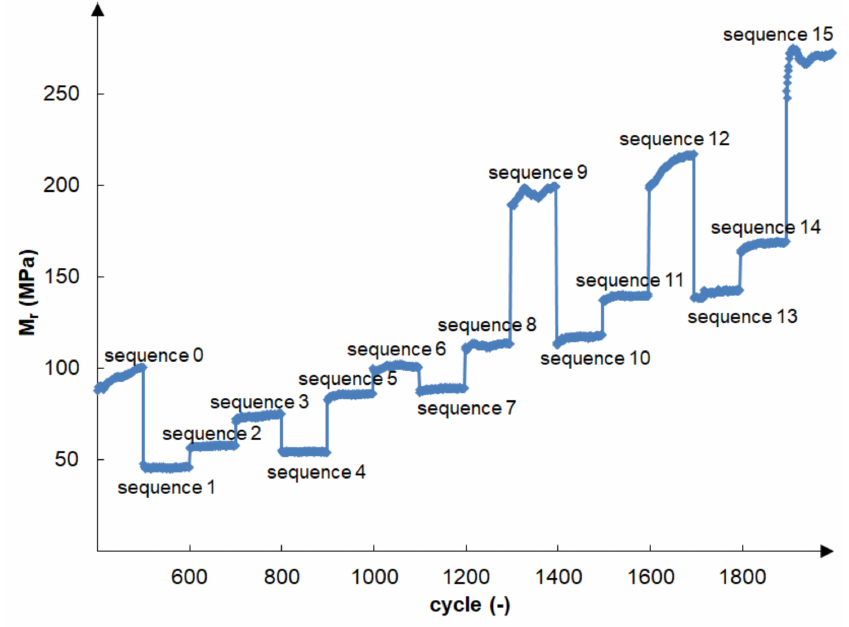
Figure 7. Variation in the resilient modulus in all test cycles (see Table 2) for sample (grSa+3.0%C) compacted by the MP method and cured for 7